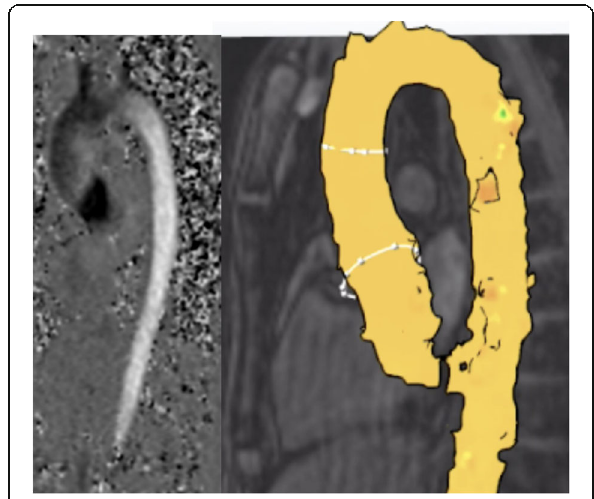
Fig. 5 Four-dimensional flow cardiac MRI analyzing different planes within the acquisition volume